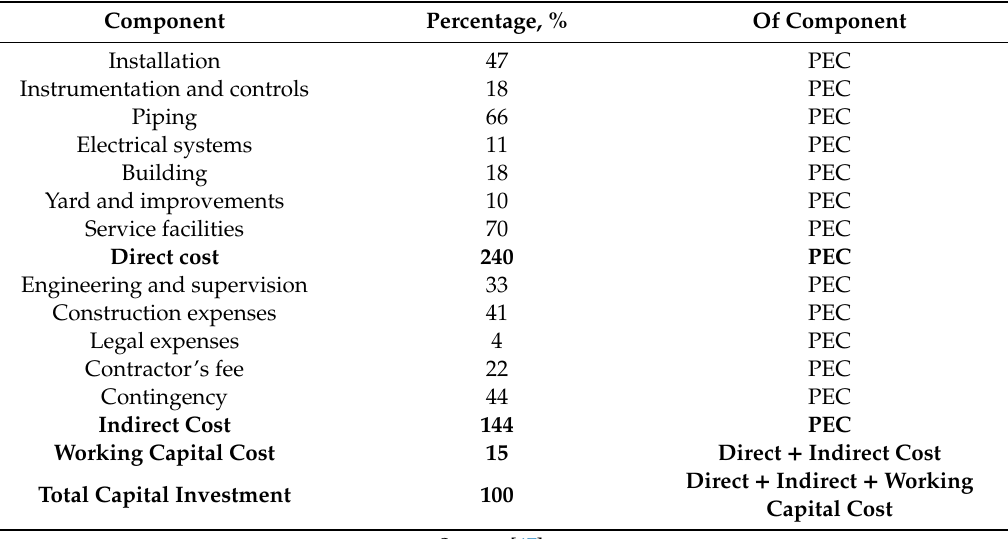
Table 4. Cost Estimation for Total Capital